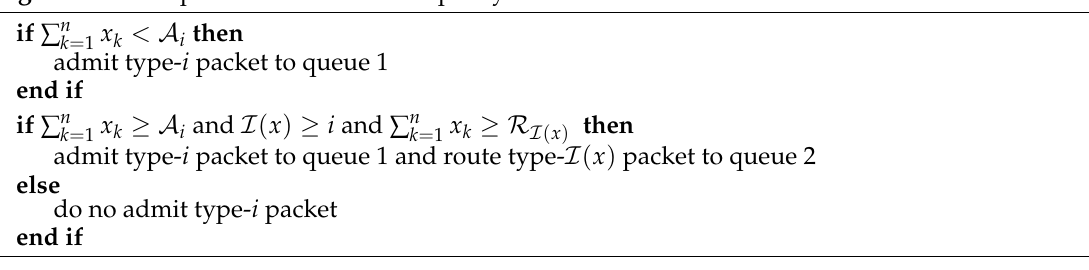
Algorithm 1. Proposed heuristic control